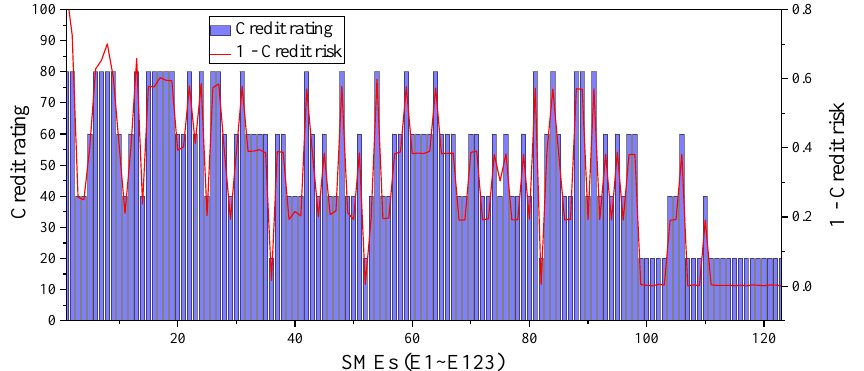
Figure 5. Tendencies of credit ratings and projected credit risks.